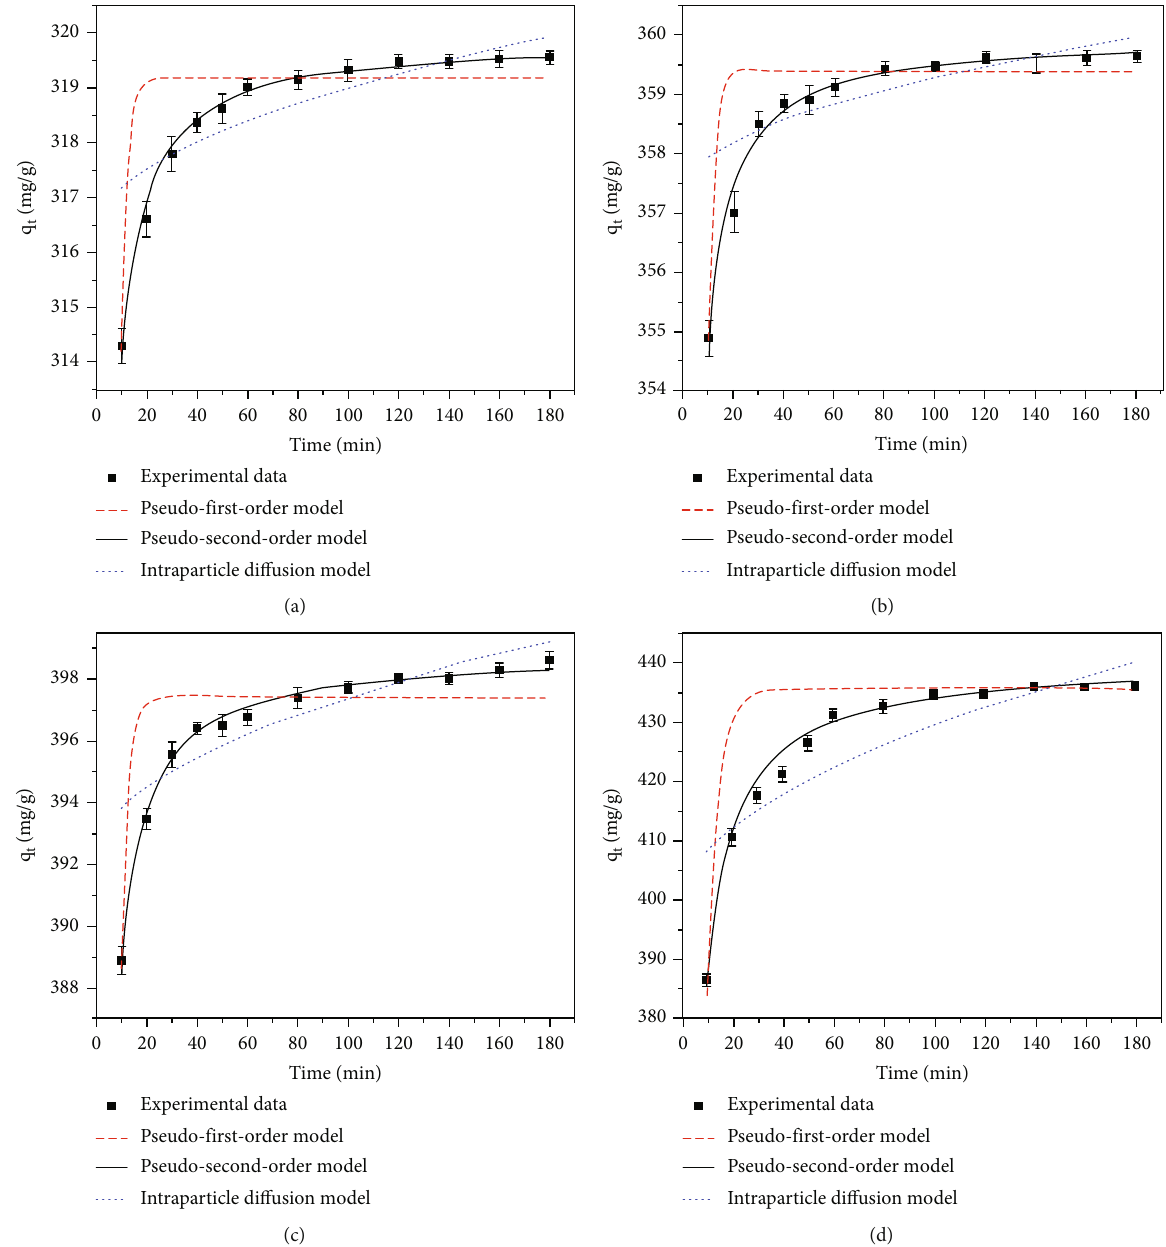
Figure 4: Fitted curves of kinetics models for di ff erent concentrations 800 mg/L (a), 900 mg/L (b), 1000 mg/L (c), and 1100 mg/L